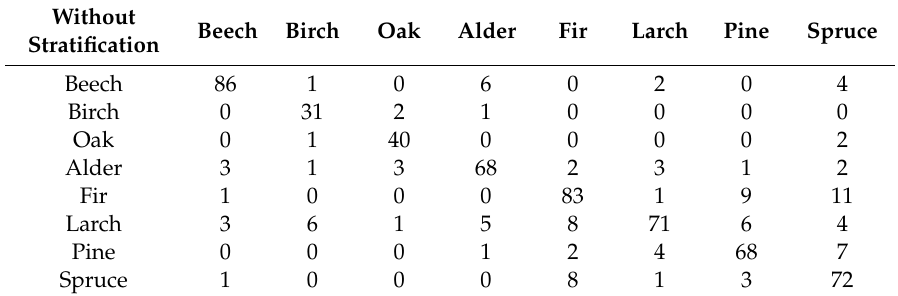
Table 5. Confusion matrix for the approach without stratification, where all eight-tree species (beech, oak, alder, birch and spruce, pine, fir, larch) were classified together inside the forest mask using the combination of multi-temporal Sentinel-2 and topographic